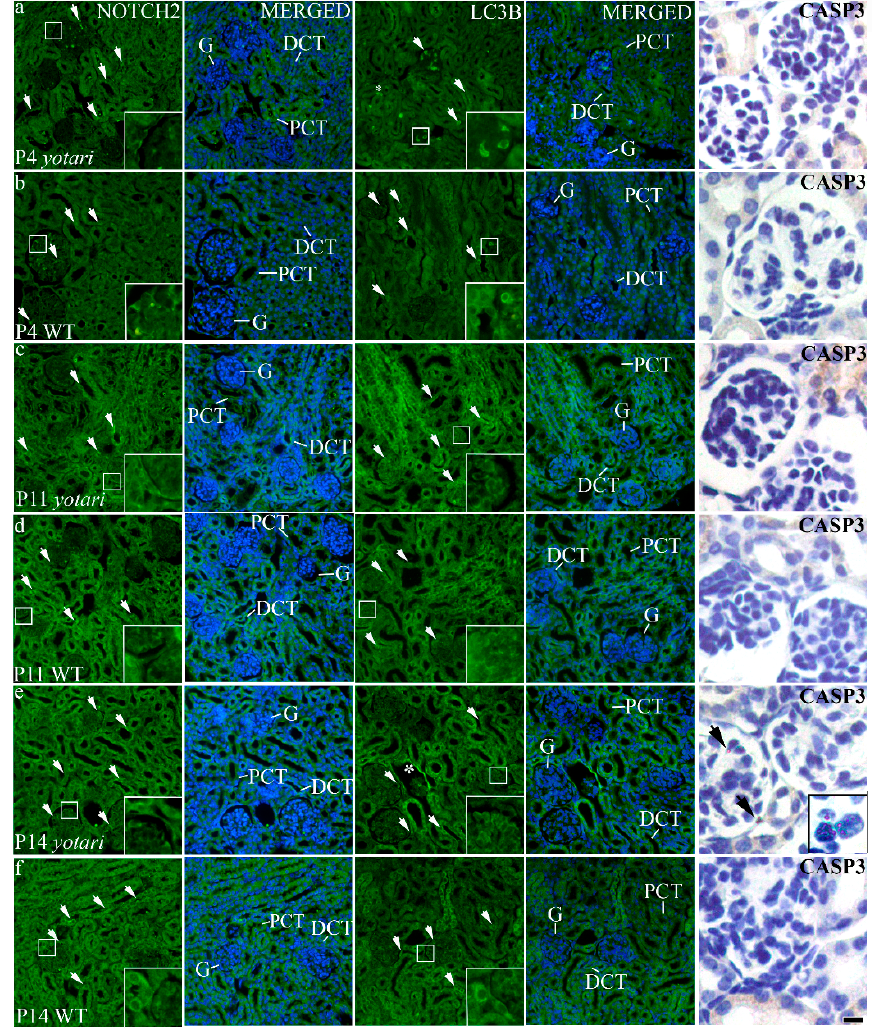
Figure 5. Immunofluorescence staining of postnatal wild-type and yotari kidneys with NOTCH2 and LC3B markers and immunoperoxidase staining with cleaved caspase3 (CASP3) marker. ( a – f ) Nuclear DNA DAPI staining is merged with NOTCH2 and LC3B. Observed time points were P4, P11, P14. Expression of the NOTCH2 and LC3B markers in the glomeruli (G), proximal convoluted tubules (PCT) and distal convoluted tubules (DCT) is marked with the arrows. Especially strong LC3B reactivity can be observed in the Bowman capsule of decaying glomeruli (asterisk, e). Inserts show the most prominent expression in the image. CASP3 was poorly expressed in all observed time points. The only significant expression was in the glomeruli of yotari mice on P14 (arrows). Scale bar is 20 µm and refers to all images.